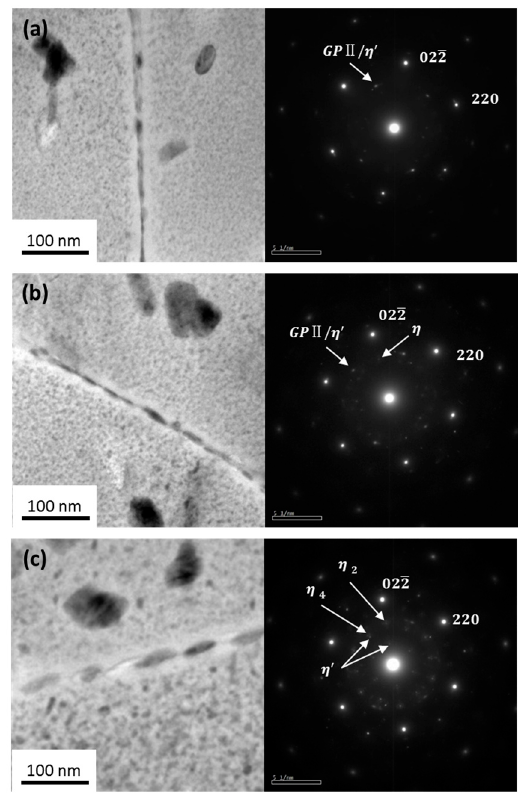
Figure 4. TEM micrographs and corresponding Selected Area Electron Diffraction pattern from <111> Al projection of the 7B04 aluminum alloy with various states: ( a ) T651 state, as ‐ received material; ( b ) retrogression heat treatment (RHT) state, 20 min at 180 °C ; ( c ) retrogression and creep aging (RCA) state, 20 h at 140 °C with applied stress of 180 MPa.